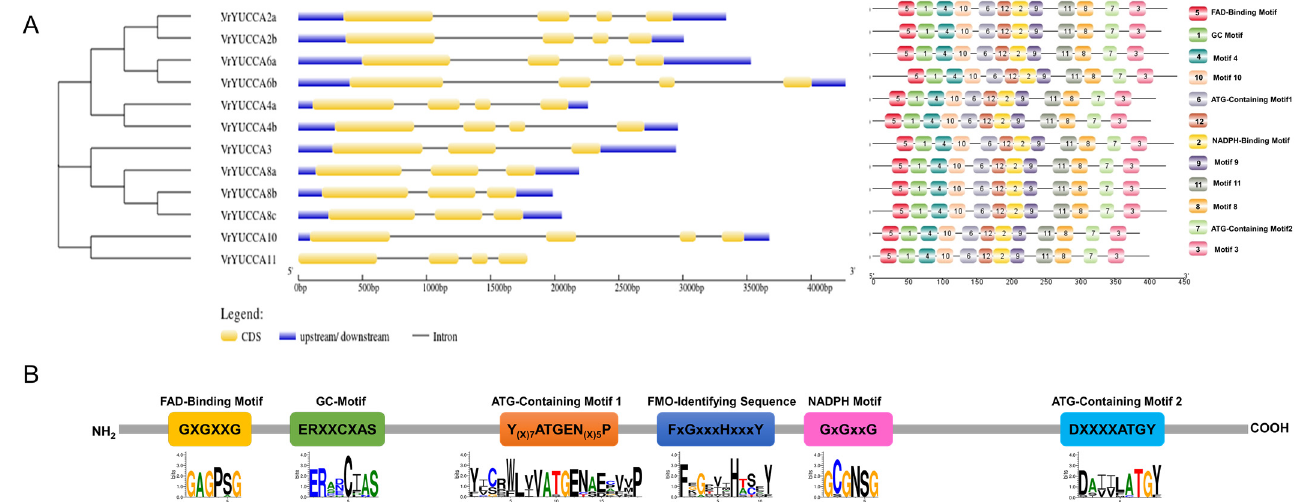
Figure 1. The gene structure and conserved motifs of the YUCCA gene family in mungbean. ( A ) Phylogenetic tree ( left ), gene structure ( middle ), and conserved motifs ( right ) of 12 VrYUCCAs . ( B ) The schematic diagram of six conserved protein motifs.